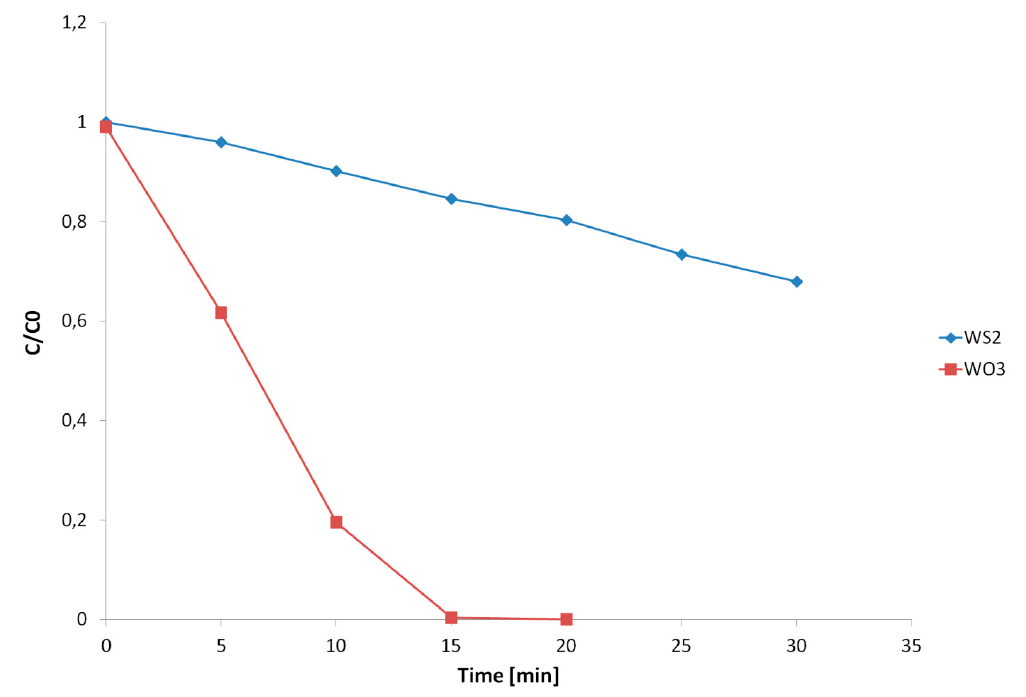
Figure 1. Kinetics of molindone photocatalytic decomposition presented as a normalized concentration (C/C 0 ) against time (min).